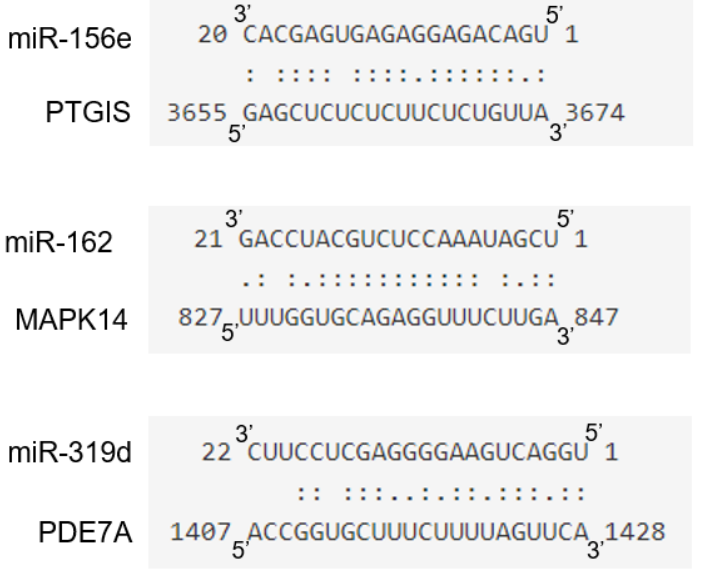
Figure 10. Diagram of putative miR-156e, miR-162, and miR-319d binding sites in PTGIS, MAPK14, and PDE7A, respectively. Paired bases are indicated by two vertical dots and a mismatch is indicated by one